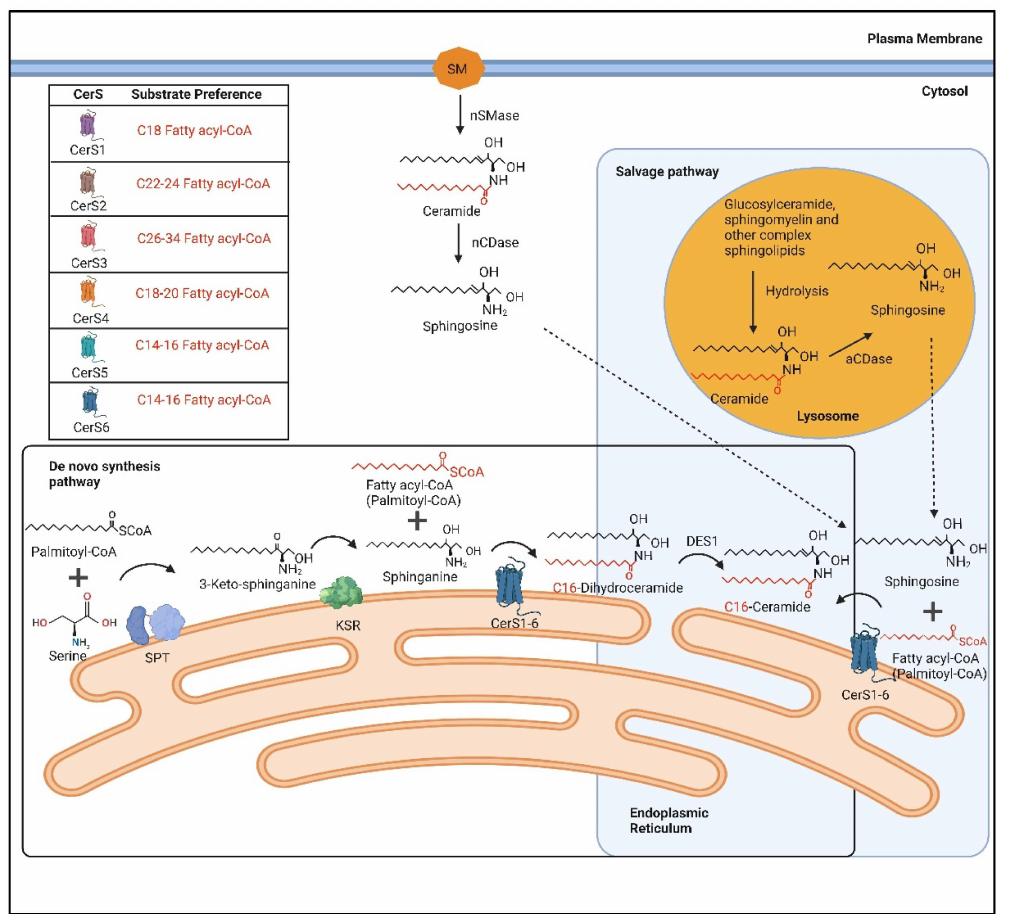
Figure 1. An illustration of the different ceramides generated either through the de novo syn- thesis, or the salvage pathway. aCDase: acid ceramidase; nCDase: neutral ceramidase; nSMase: neutral sphingomyelinase; CerS: ceramide synthases; DES1: dihydroceramide desaturase-1; KSR: 3-ketosphinganine reductase; SPT: serine palmitoyltransferase. Created with